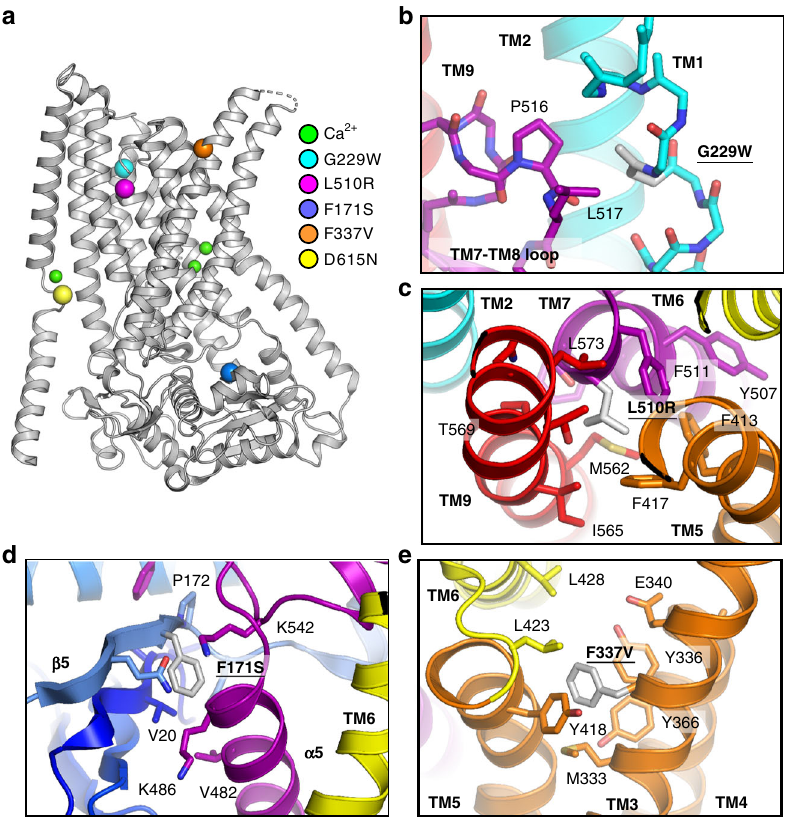
Fig. 9 Missense variants in TMEM16K found in patients with SCAR10 ataxia. a Overview of TMEM16K with disease-associated missense mutation locations shown as coloured spheres and Ca 2 + ions shown as smaller green spheres. Local environment for the disease associated mutations: b Gly229Trp, c Leu510Arg, d Phe171Ser and e